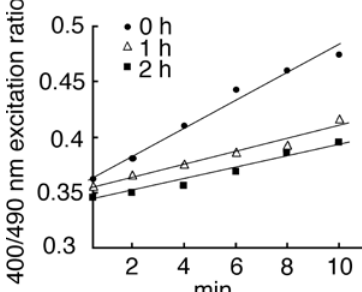
Appendix Figure 2. Auto-oxidation measurement of roGFP2 in E. coli cells and time dependent relief from turbulence. Fluorescence was measured spectrophotometrically, immediately after preparing the cell suspension (0 h) and after settling the cells for 1 h (1 h) and 2 h (2